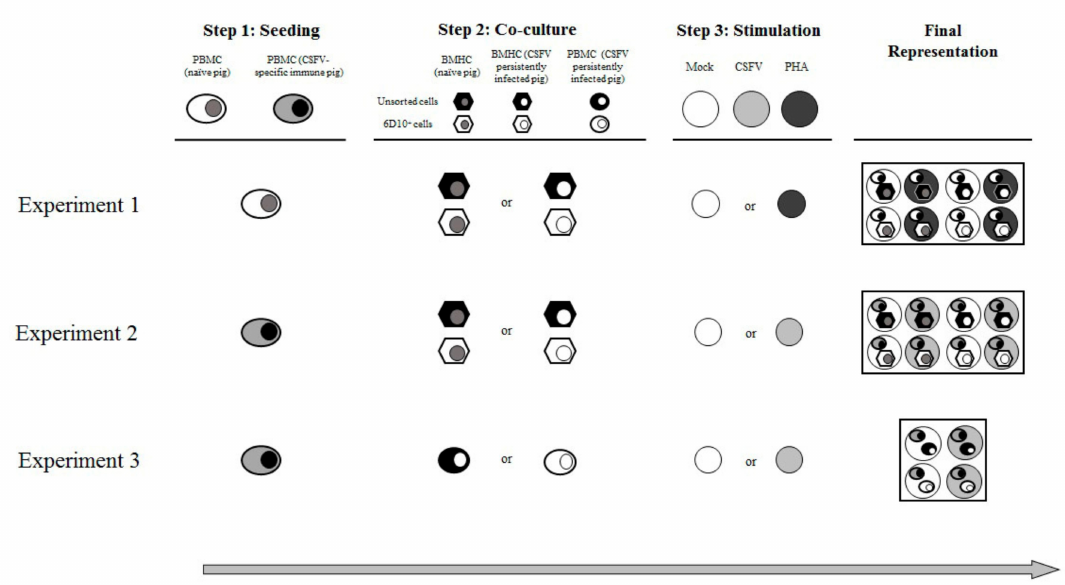
Figure 1. Illustration of the co-culture experiment layout. The figure shows an overview of the di ff erent cell combinations and experimental conditions tested. Three experiments were carried out, each of them consisting of three steps. Step 1: seeding, step 2: co-culture, and step 3: stimulation. A final representation of the cells and stimuli included in the wells for each experiment is also